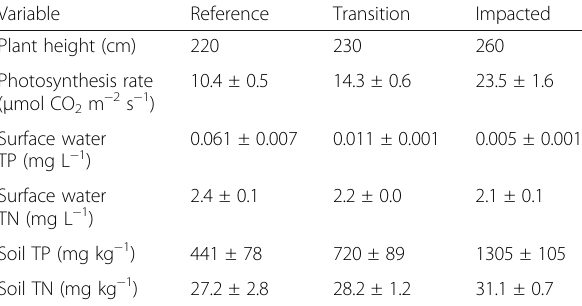
Table 2 Mean biomass, height and photosynthesis rate of cattail and surface water and soil nutrients in reference, transition, and impacted zone of the Florida Everglades (Water Conservation Area 2A). Except data for cattail photosynthesis (Wang et al. 2015), all data are taken from Miao and Sklar (1997) Variable